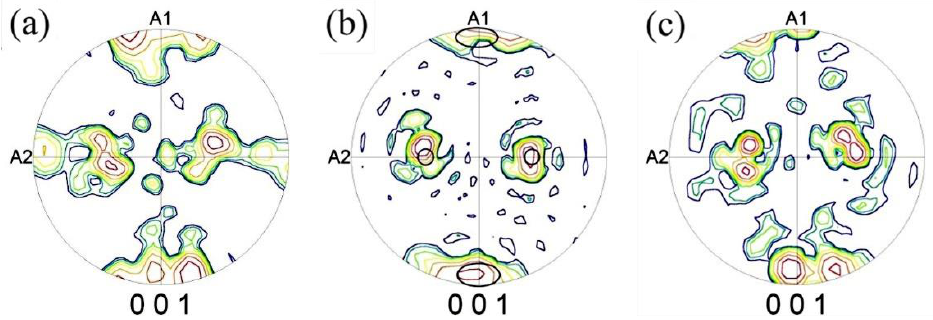
Figure 9. The {001} pole figures after high-temperature annealing with different decarbonization annealing times of ( a ) 3 min, ( b ) 5 min and ( c ) 7 min. Table 4. Magnetic properties after high-temperature annealing with different decarbonization an- nealing